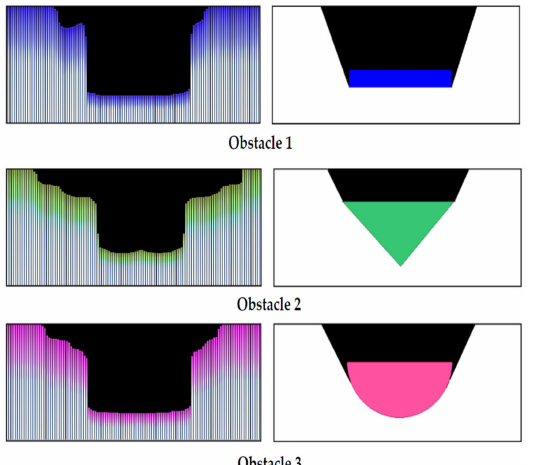
Figure 21. The difference between the real shapes ( right ) and those determined by the radar ( left